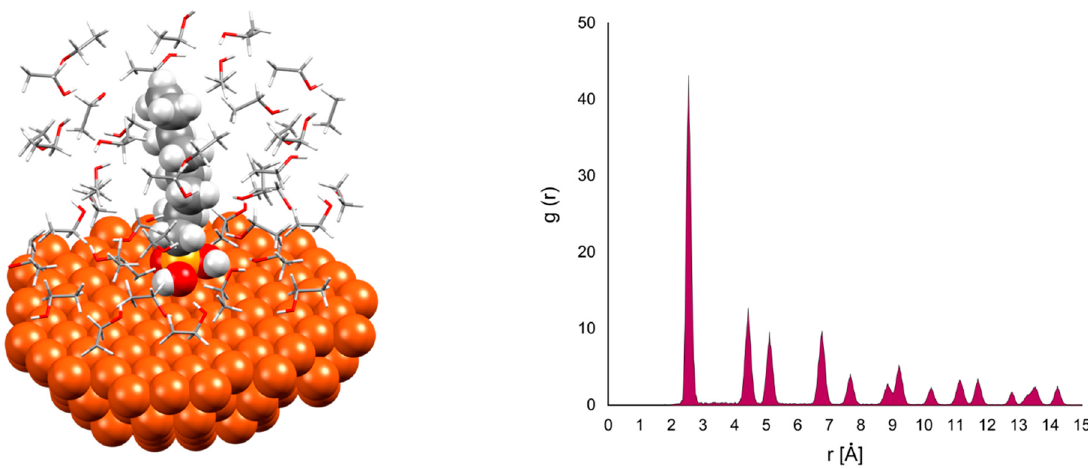
Figure 10. The final geometry of the MD simulation // forcefield = Condensed-phase Optimized Molecular Potentials for Atomistic Simulation Studies, NVT canonical ensemble at 298 K //. The time step for MD was 1 fs with a total simulation time of 500 ps, system temperature was maintained using a Berendsen Thermostat (0.1 ps decay constant). For the data analysis, 500 ps of trajectory frames were used.